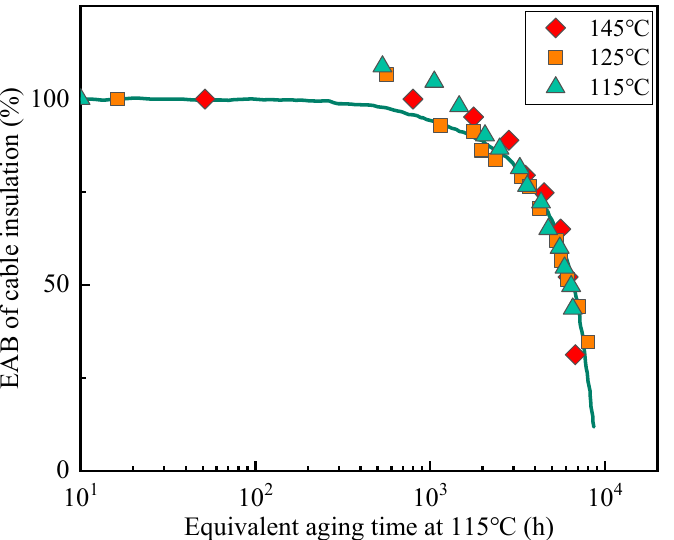
Figure 2. Time-temperature superposition of the elongation results from Figure 1 at 115 °C. The derived multiplicative shift factors can be plotted on an Arrhenius plot (log of α versus the inverse absolute temperature) to see if Arrhenius behavior is observed [13]. The Arrhenius plot was shown in Figure 3. By continuing the fitting to the data in Figure 3, the linearity is up to 0.997 and the linear fitting equation was presented in Equation (8).